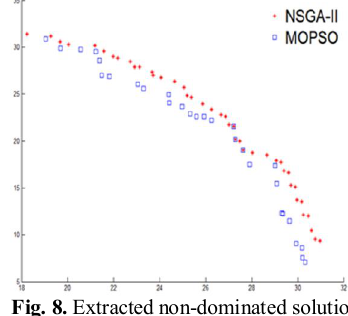
Fig. 6. Extracted non-dominated solutions by different approaches for permutation problem with 7 alternatives